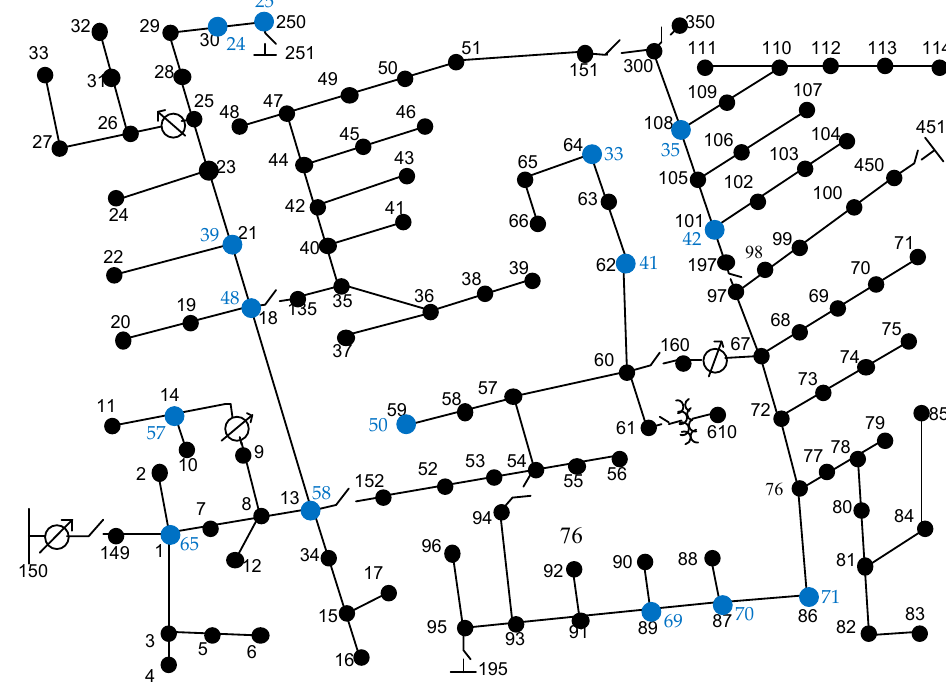
Figure 14. The locations of potential charging stations in the power grid.